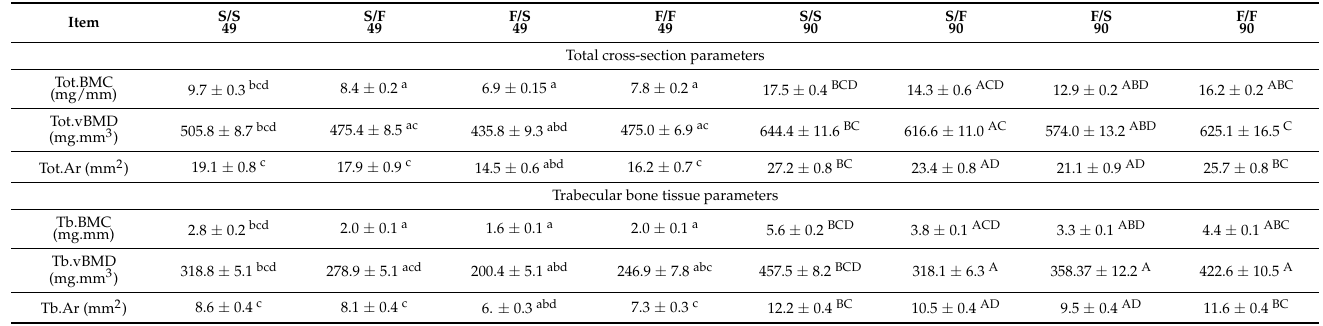
Table 3. Tomographic (pQCT) analysis in the distal femur